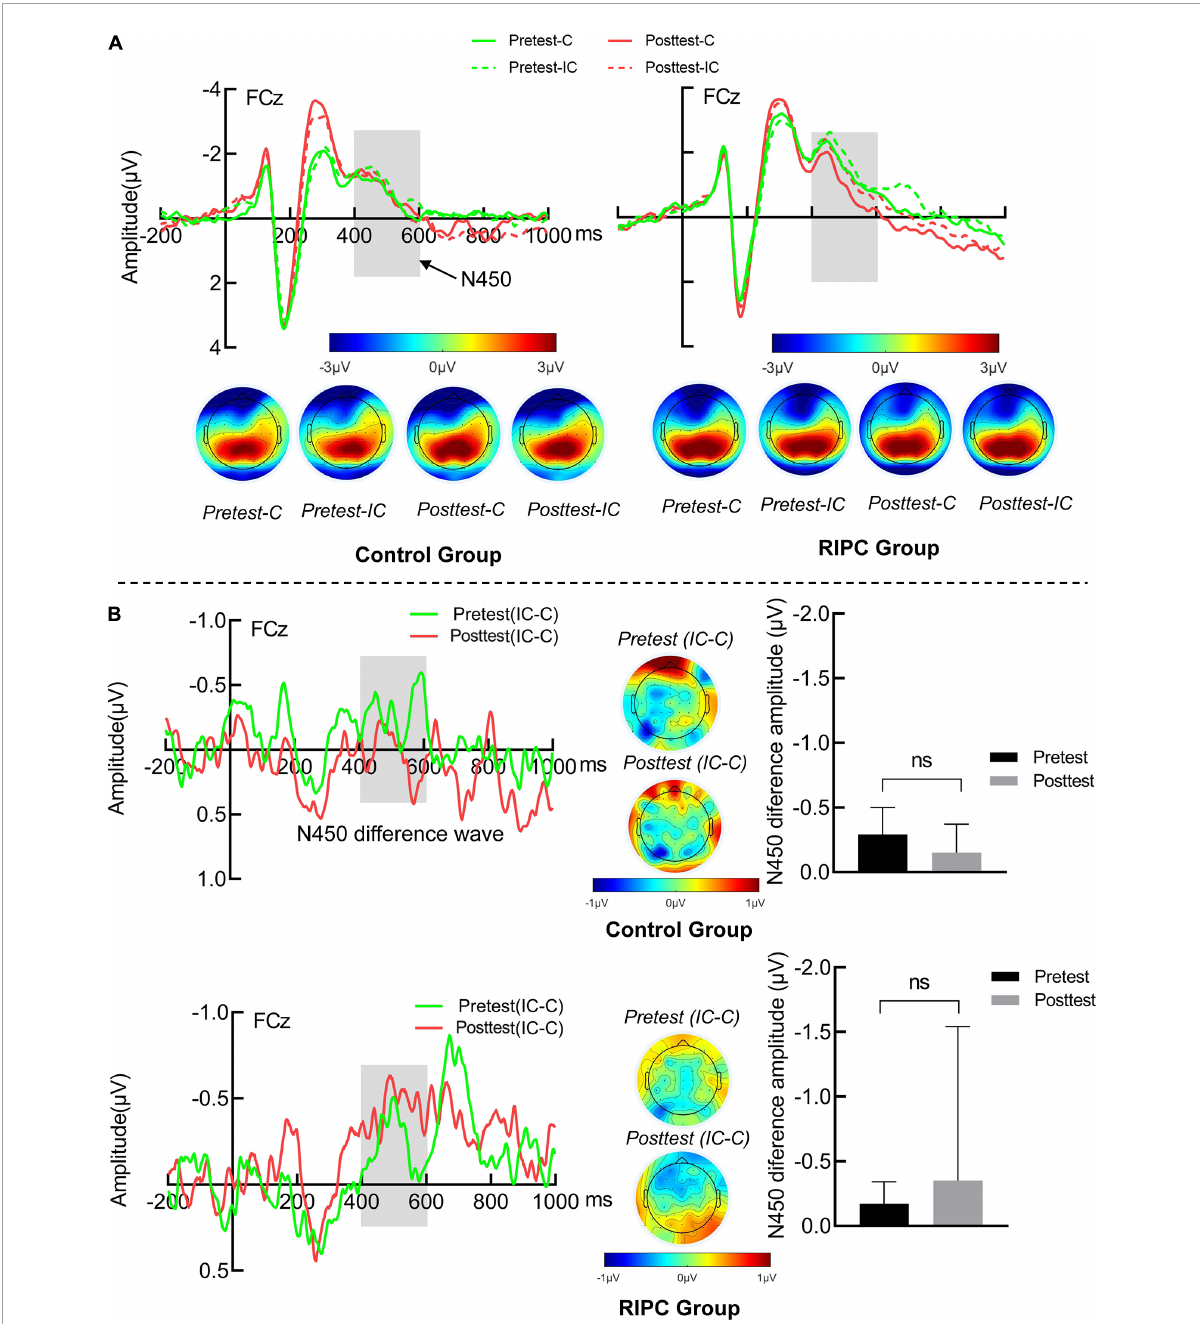
FIGURE4 (A) The N450 grand average waveform (FCz) and topographical map of two groups. (B) The averaged difference wave and topographical map of N450 in two groups. The dark gray rectangles represent the measure time window of N450. Error bar represents the stand error; Pretest: before treatment, Posttest: immediately after treatment. C: Congruent, IC: Incongruent, IC-C: Incongruent minus Congruent. ns, no significance between the average difference wave of pretest and posttest.